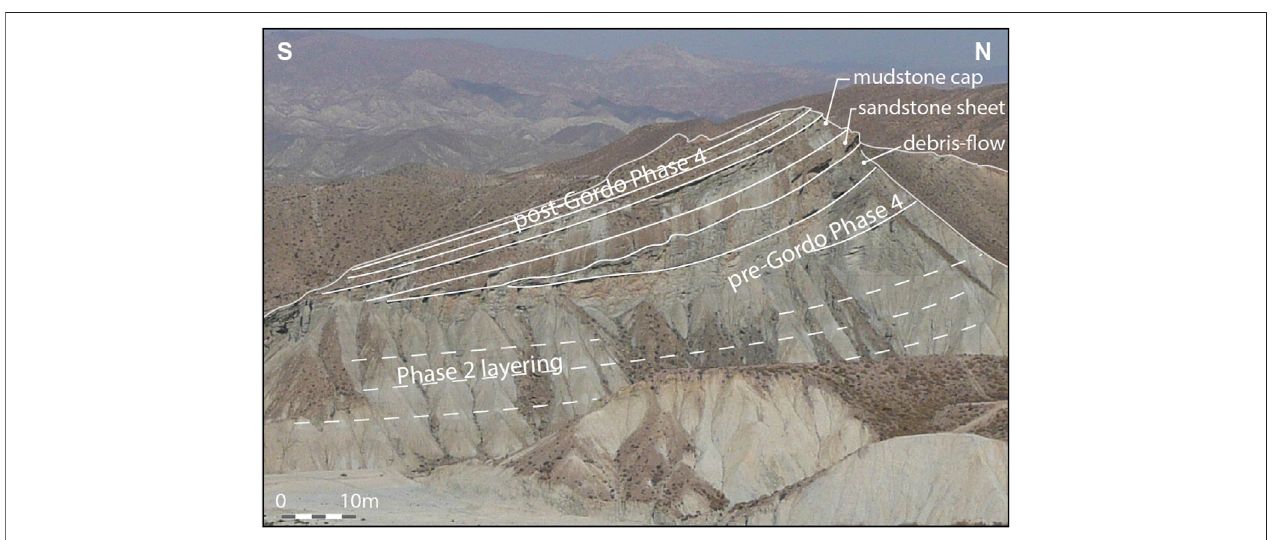
FIGURE 13 | Photograph and line drawing of the Gordo megabed onlapping directly onto tilted Phase 2 marls associated with the southern onlap slope (see Figure 4 for location). Each division of the Gordo megabed (debris- fl ow, sandstone sheet and mudstone cap) pinches-out in turn against the slope.